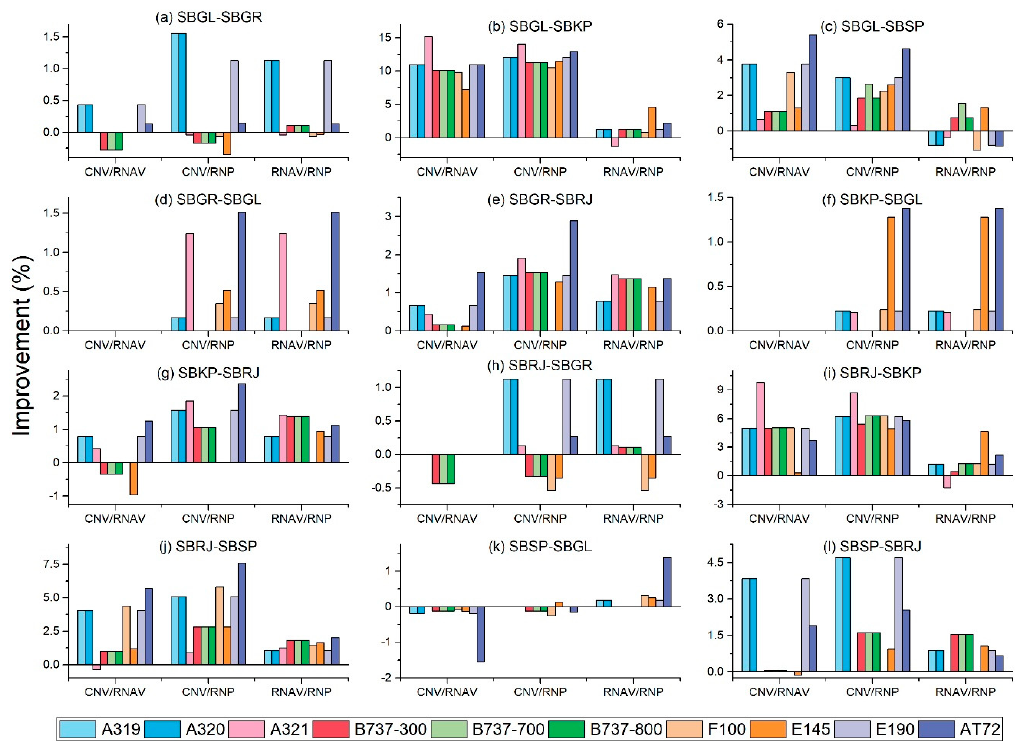
Energies 2021 , 14 , x FOR PEER REVIEW 11 of 19 Figure 4. Case 1 route percentage improvement by route. ( a ) SBGL-SBGR; ( b ) SBGL-SBKP; ( c ) SBGL-SBSP; ( d ) SBGR-SBGL; ( e ) SBGR-SBRJ; ( f ) SBKP-SBGL; ( g ) SBKP-SBRJ; ( h ) SBRJ-SBGR; ( i ) SBRJ-SBKP; ( j ) SBRJ-SBSP; ( k ) SBSP-SBGL; ( l ) SBSP-SBRJ.